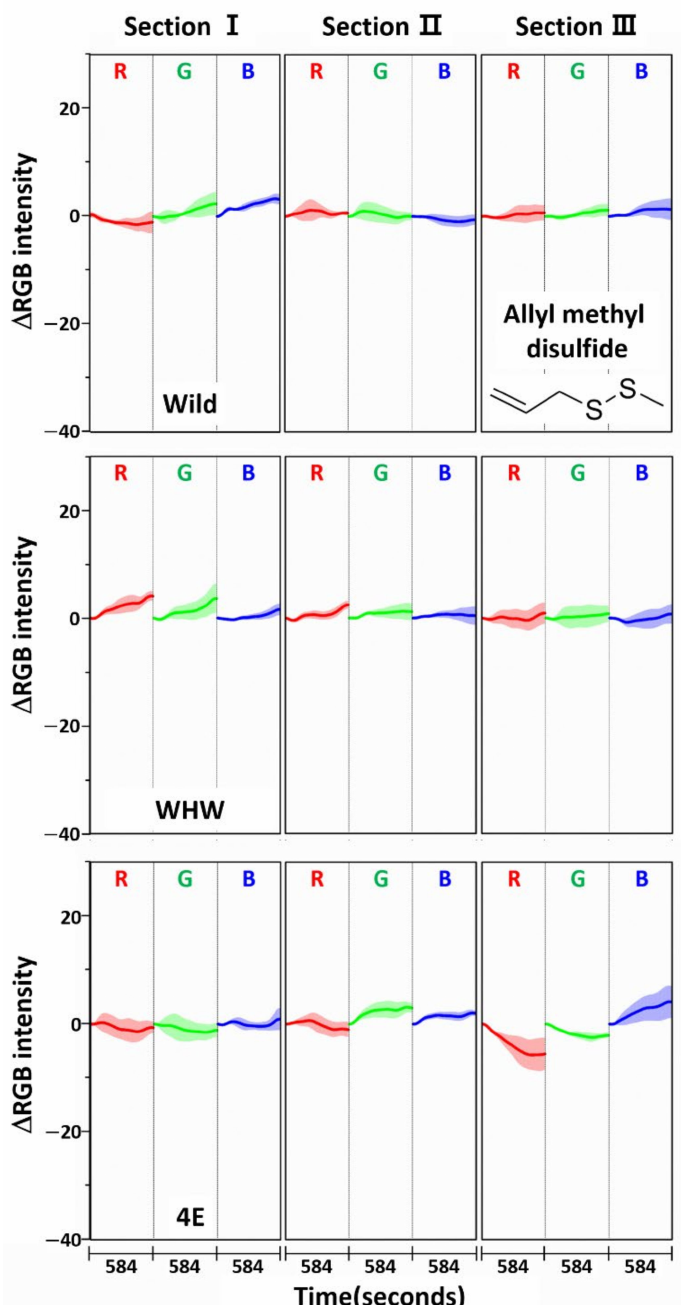
Figure 8. Average ∆ RGB intensity of allyl methyl disulfide individually acquired using Wild, WHW, and 4E sensors. The molecular structure of allyl methyl disulfide is also